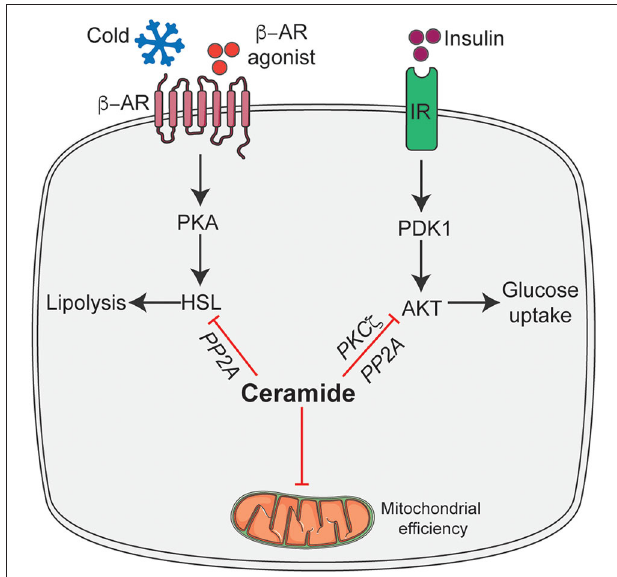
FIGURE 2 | Schematic of ceramide dependent molecular mechanisms that modulate adipocyte function. Ceramides gauge adipocyte energy stores via the following mechanisms: inhibit insulin-stimulated Akt/PKB thus inhibiting glucose uptake and metabolism; inhibit HSL activation in response to β -adrenergic receptor activation thereby attenuating lipolysis and release of free fatty acid and inhibit mitochondrial efficiency. β -AR, β -adrenergic receptor; IR, Insulin receptor; HSL, Hormone sensitive lipase; Akt/PKB, Protein kinase B; PDK1, phosphoinositide dependent kinase-1; PKA, Protein kinase A; PP2A, Protein phosphatase 2A; PKC ζ , protein kinase C ζ . This figure was drawn using the Servier